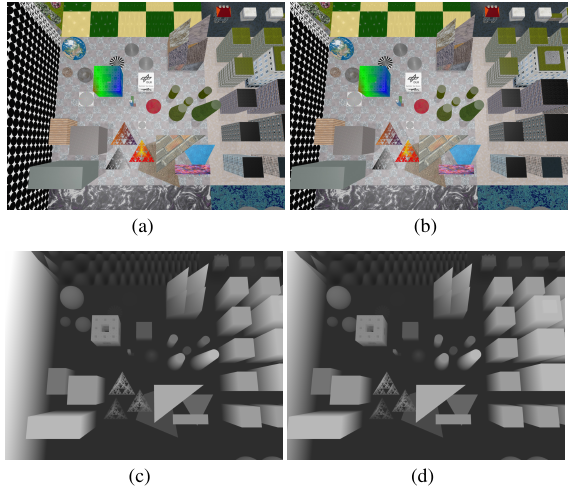
Figure 6. Synthetic reference data (a) left image, (b) right image, (c) left z bitmap, (d) right z bitmap and P 2 = 100 for slowly and rapidly changing depths. The lower and upper disparity bounds estimated on all levels of the matching pyramid are widened by 20 pixels to absorb